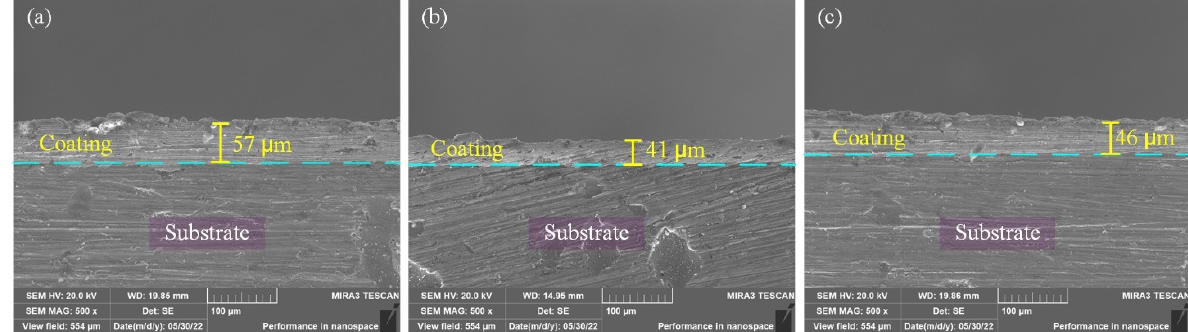
Figure 4. SEM images for the cross-section. ( a ) E1 sample; ( b ) E2 sample; ( c ) E3 sample.